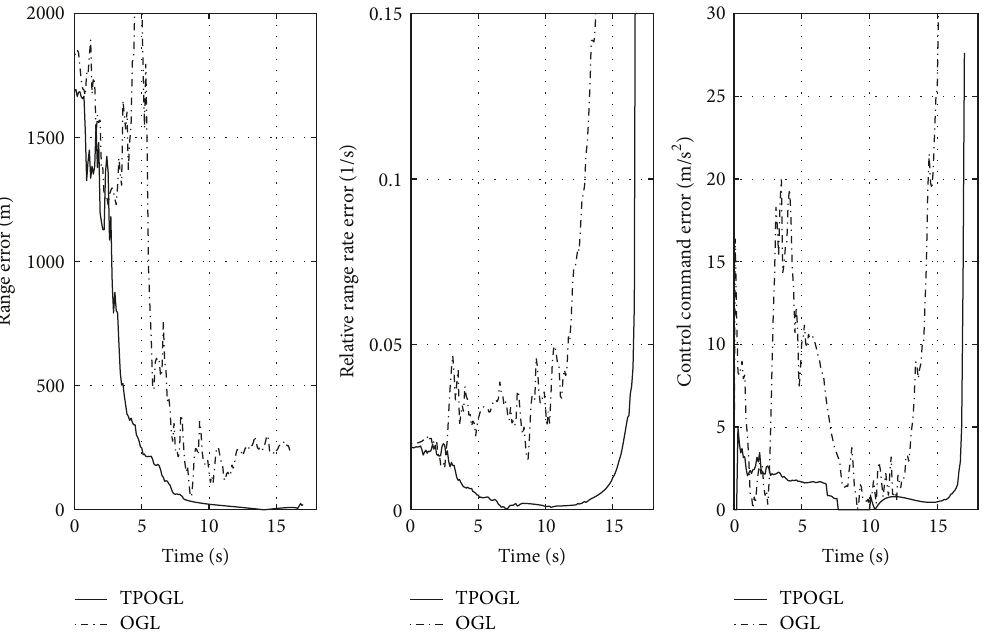
Figure 7: Estimation errors comparisons against stationary